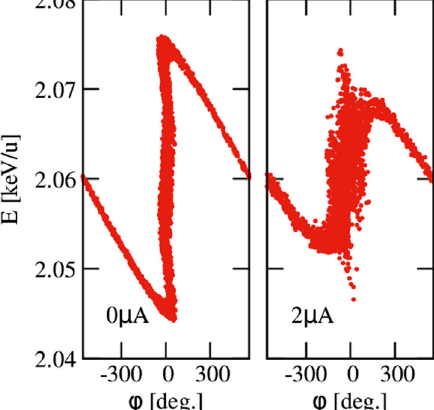
FIG. 1. PARMELA multiparticle simulation of the effects of space charge on the longitudinal ISAC-RFQ time focus, for a mass 30 beam, corresponding to the upper limit of RFQ mass to charge acceptance. The three-harmonic modulation, which de- fines the time focus after a 5 m drift from prebuncher to RFQ, begins to degrade as the bunch exceeds roughly 1 μ A in beam intensity, with a 2 μ A simulation shown for clarity. X-axis units are degrees at 35.36 MHz, the ISAC-RFQ operating frequency.